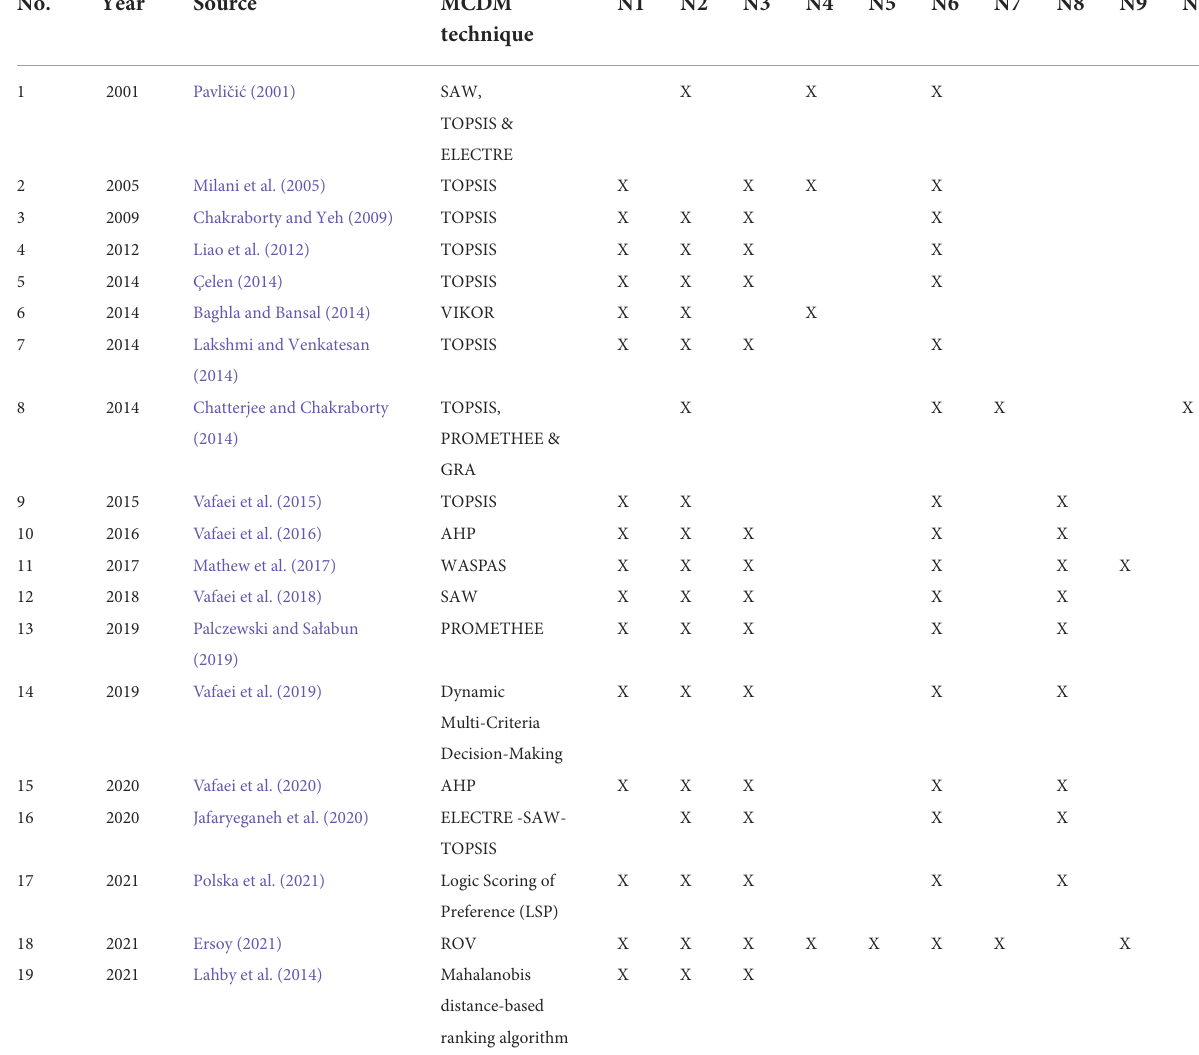
TABLE 1 Summary of articles according to MCDM technique and normalization